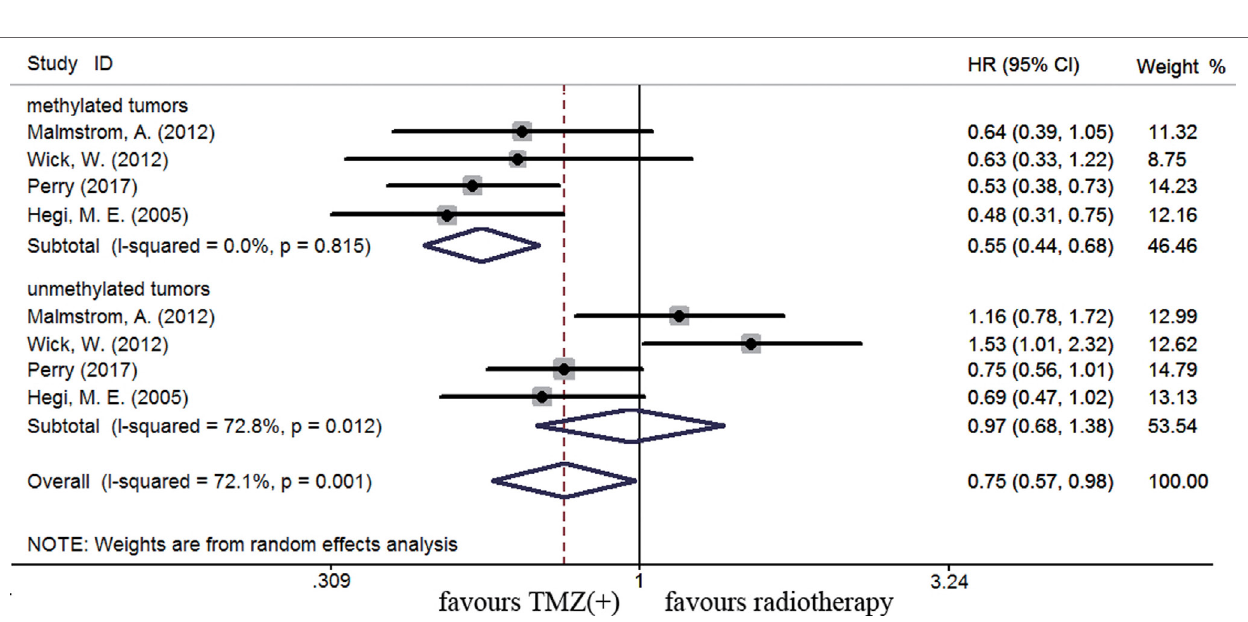
FiGURe 6 | Calculated HRs and 95% CIs for the relationship between methylation and OS benefit from TMZ-containing or TMZ-free therapy in elderly GBM patients (methylated vs. unmethylated